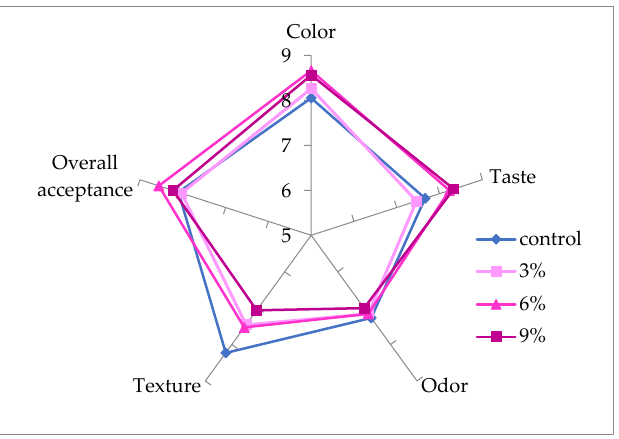
Figure 2. Sensory evaluation of probiotic ice creams supplemented with CCP.